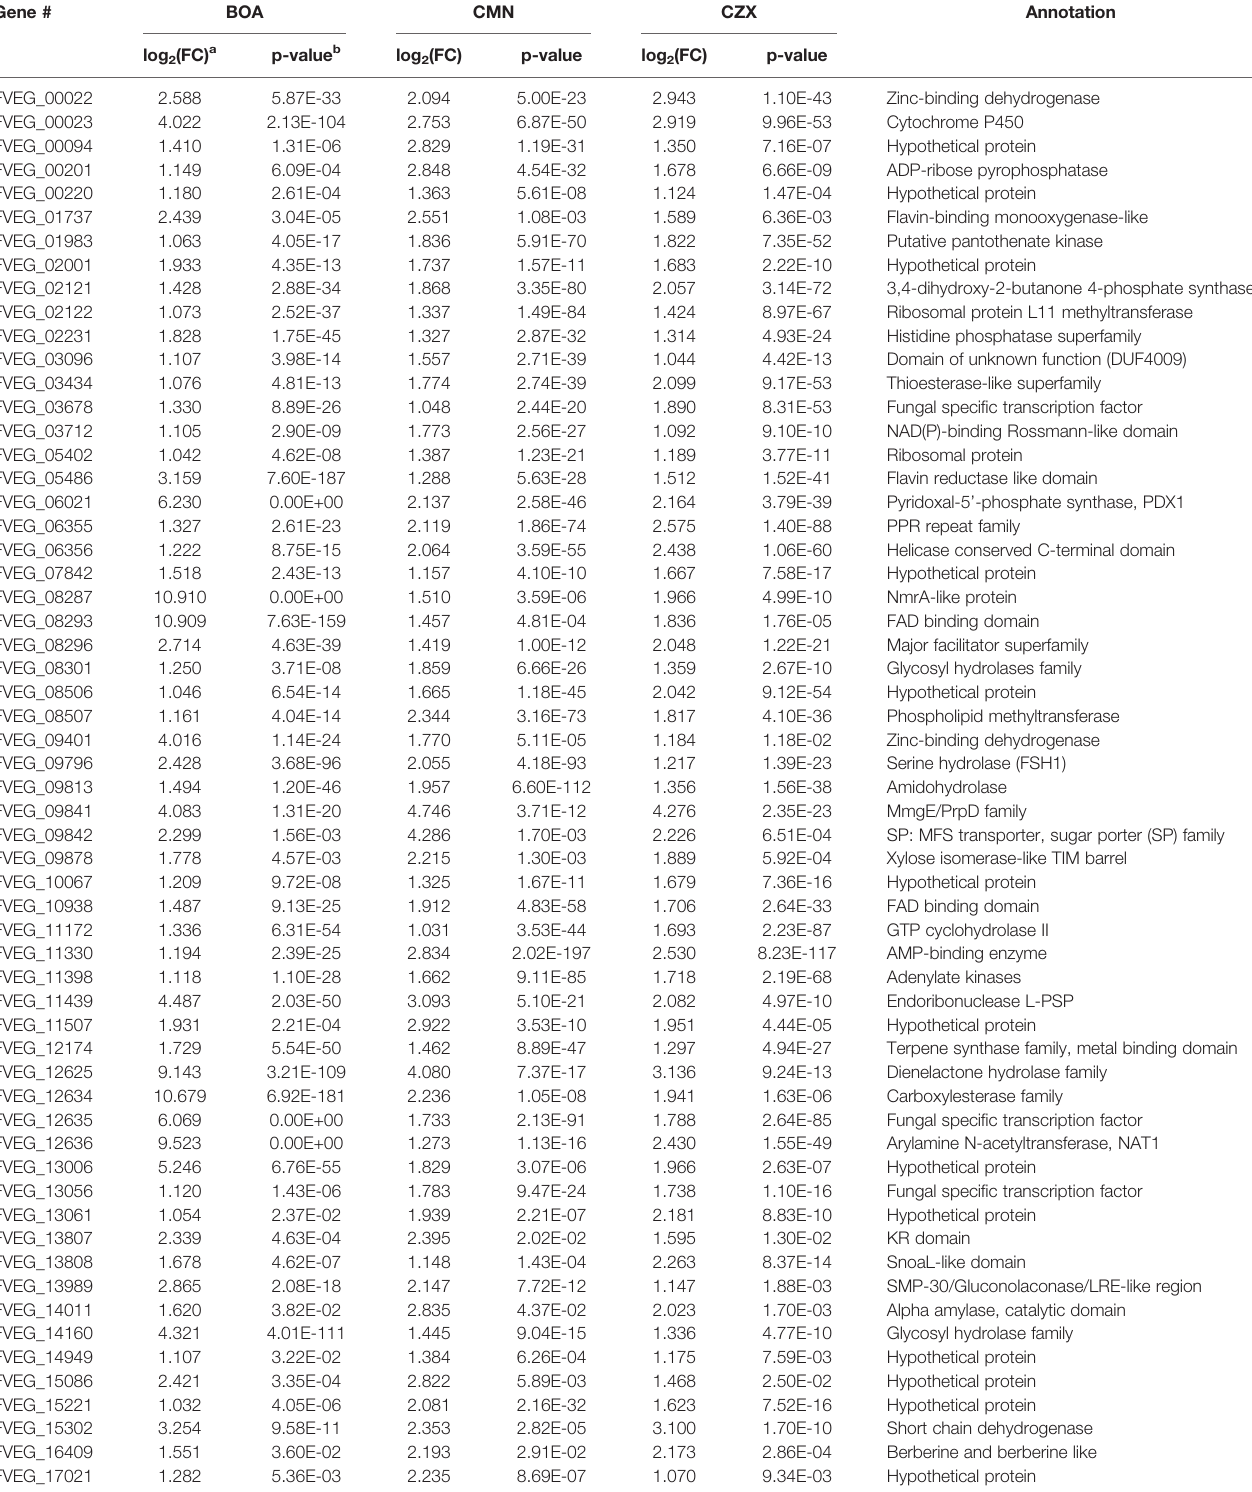
TABLE 7 | Shared induced genes exclusively among BOA, CMN, and CZX